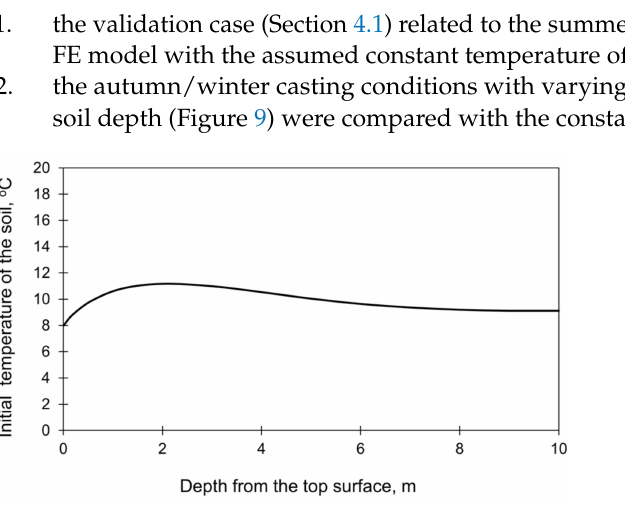
Figure 9. Initial temperature distribution at the soil depth in the autumn/winter seasons